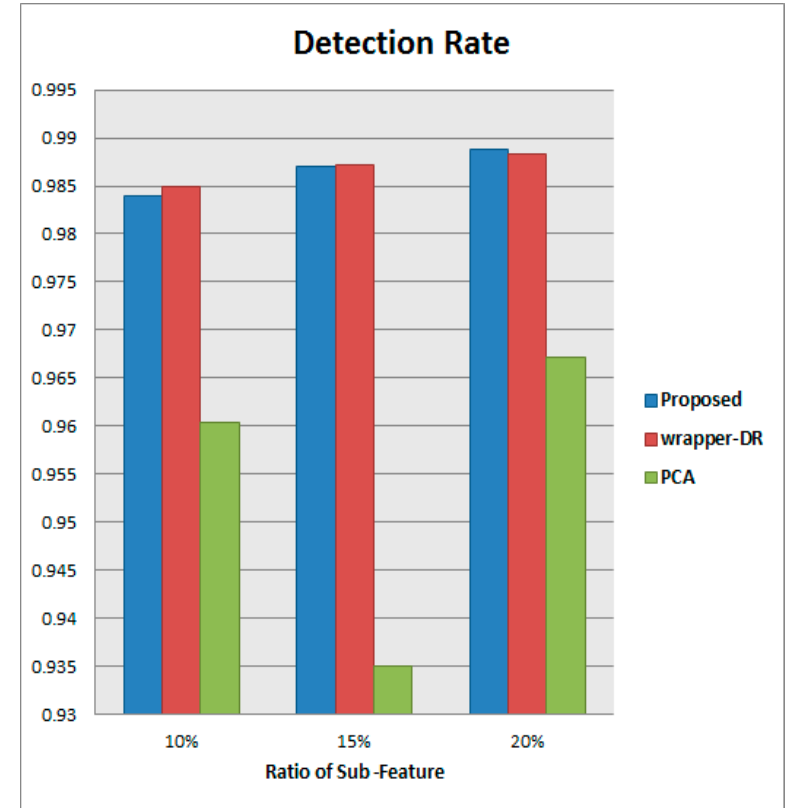
Figure 6. Result of detection rate.